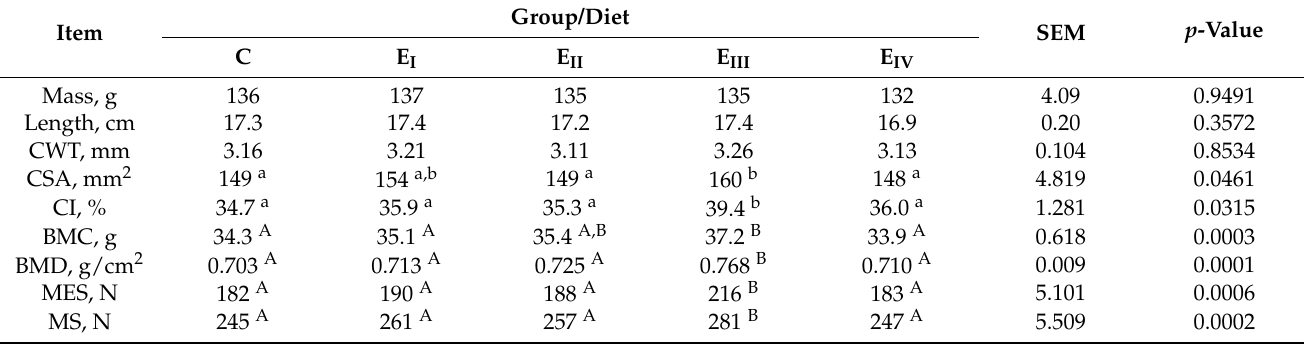
Table 4. Femur morphometric, geometric, densitometric, and biomechanical properties at the end of the study in